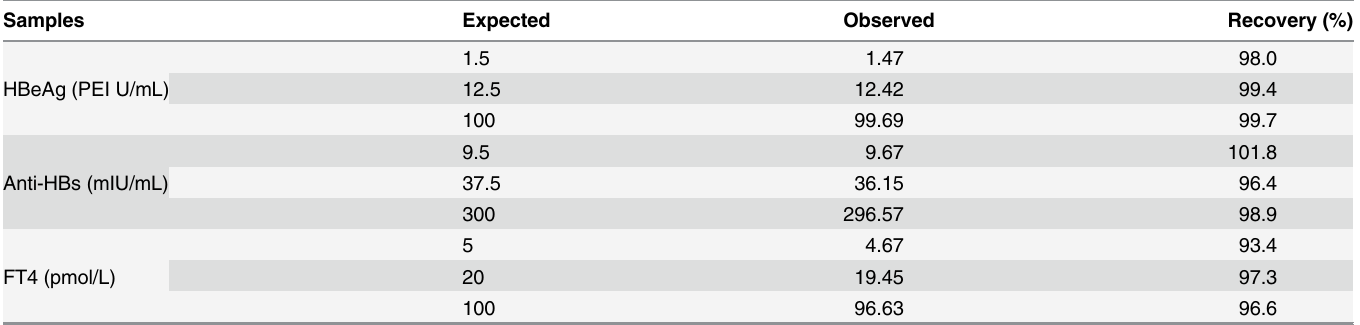
Table 2. Accuracy of MMPs-TRFIA was calculated by measuring seril dilutions of known concentration substances and these results were com- pared to the quantity's actual value. Samples